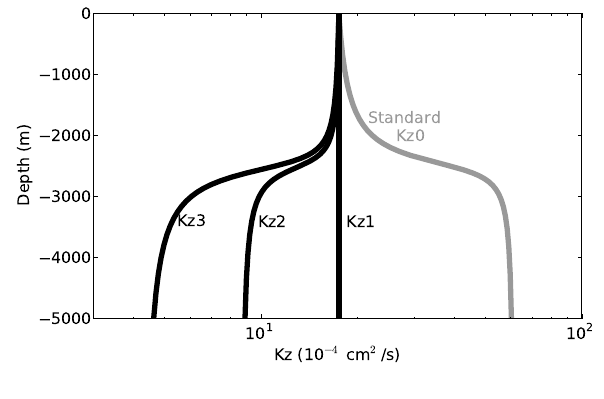
Fig. 7. Vertical diffusion coefficient profiles imposed in the simulations. Kz0 is the standard profile, Kz1, 2 and 3 are the low diffusion profiles used to test the impact of deep low diffusion.